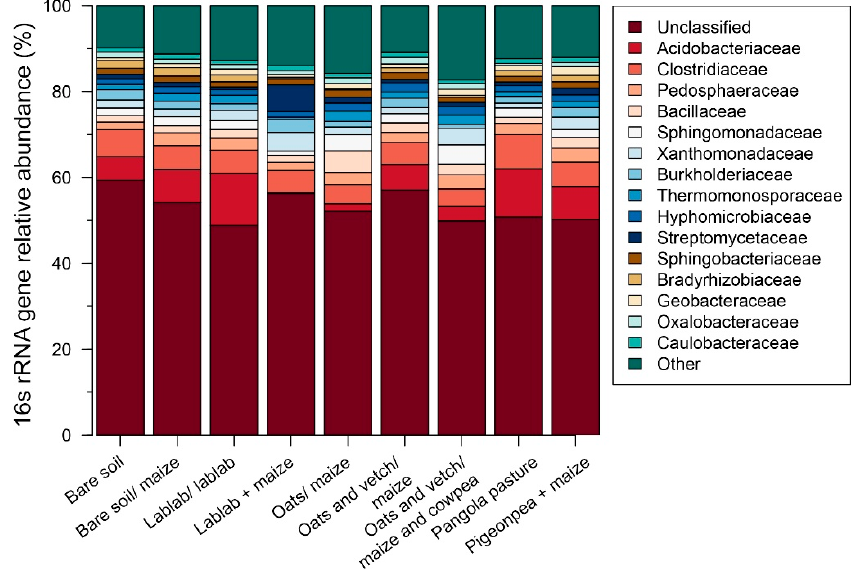
Figure 4. Family-level analysis of 16 s RNA-based relative abundances.